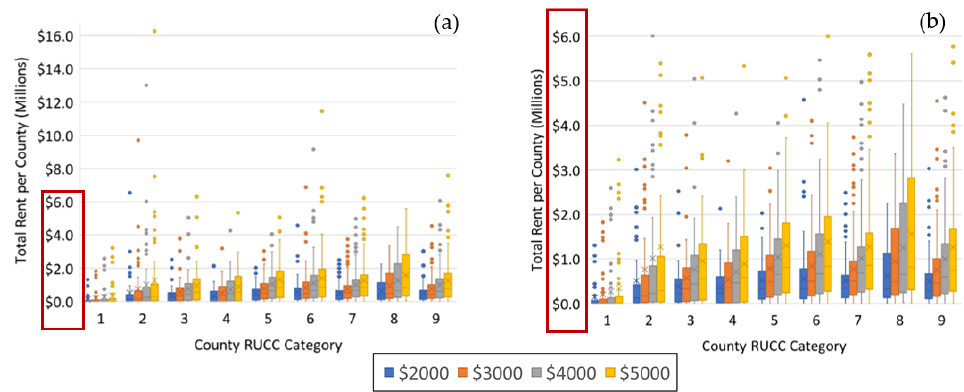
Figure 11. Box and whisker plots displaying variation in annual rent received by counties from wind turbines considering four potential rental brackets for diverse NPC. ( a ) Chart with extended vertical axis ranges. ( b ) Chart with limited vertical axis range.